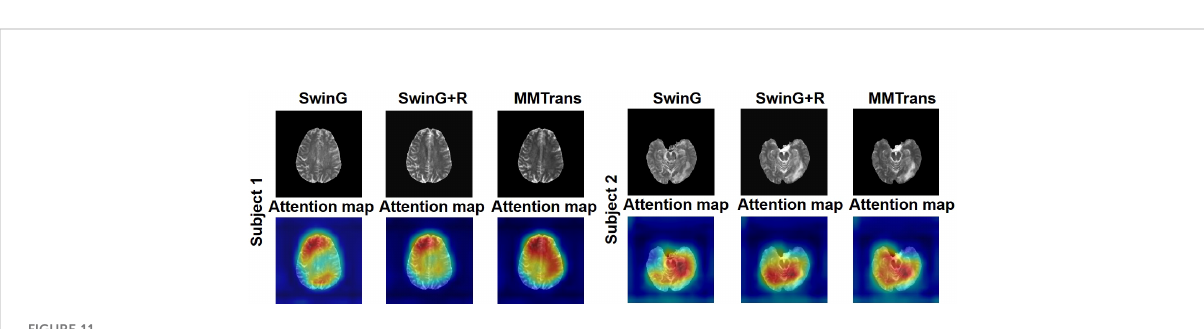
FIGURE 11 The learned attention map. Visualization of attention maps in SwinG, SwinG+R, and MMTrans. Blue and red values represent low and high response values, respectively.